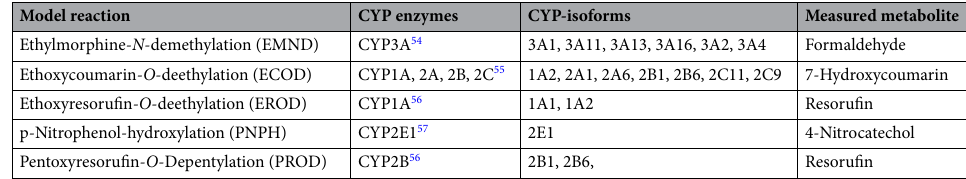
Table 3. Model reaction to assess CYP-activity.